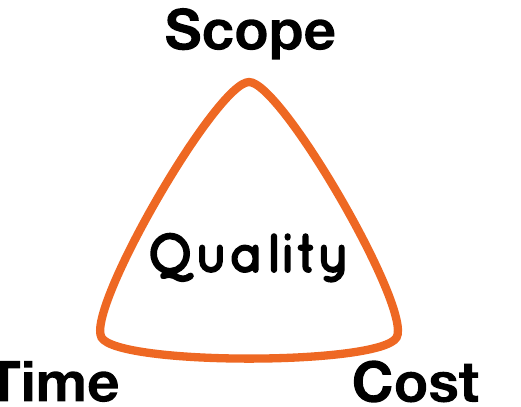
Figure 6. Project management triangle. This work focuses on three characteristics, the scope of the development is the independent variable and has a fixed size, time and cost are based on the product backlog defined at the